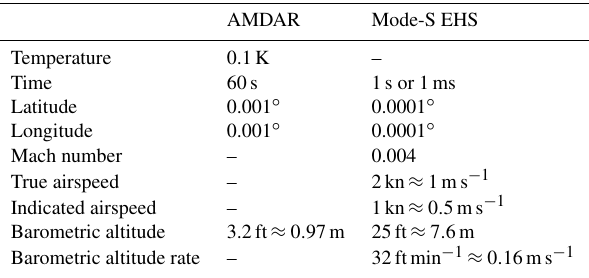
Table 1. Time and position resolution of AMDAR and Mode-S